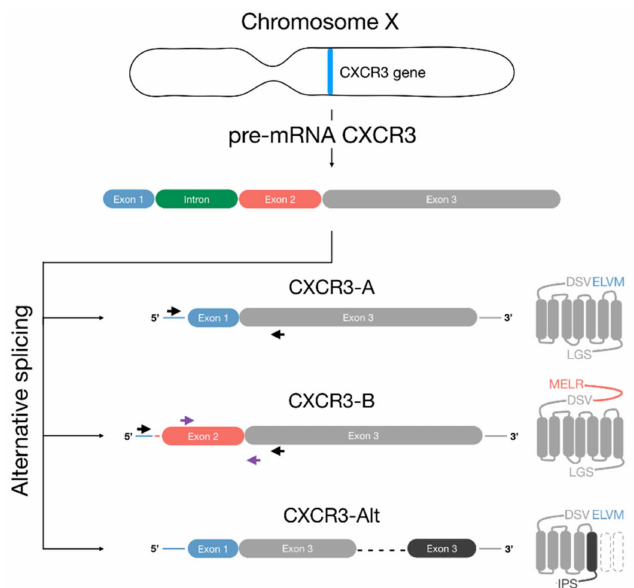
Figure 1. Schematic representation of CXCR3 variants. Due to alternative splicing of the pre-mRNA of the CXCR3 gene, located in chromosome X, three CXCR3 variants can be generated. The CXCR3-A variant is the product of the splicing of the exon 1 and exon 3 within the CXCR3 gene. The assembly of exon 2 and exon 3 results in the CXCR3-B variant, which has an N terminus longer by 52 amino acids (AAs) compared with CXCR3-A. The removal of the intron, exon 2, and a 337-bp region within the third exon during RNA splicing results in the CXCR3-Alt variant that comprises the N terminus and the first four transmembrane domains identical to CXCR3-A, as well as a possible fifth transmembrane region and a C terminus which are di ff erent from CXCR3-A and -B. The primers used to detect CXCR3-A, which also recognize CXCR3-B, and CXCR3-B are represented by the black and purple arrows,